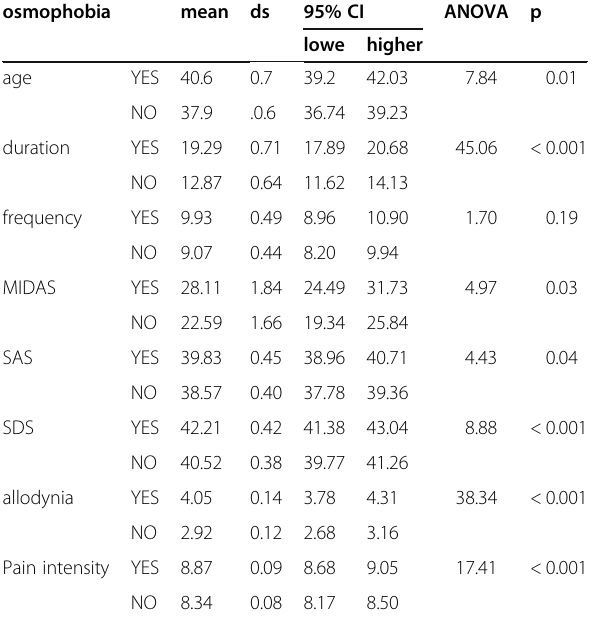
Table 1 Mean, Standard Errors, 95% Confidence Intervals and results of ANOVA analysis for single variables in the total cohort of migraine patients, including MO, MA and CM